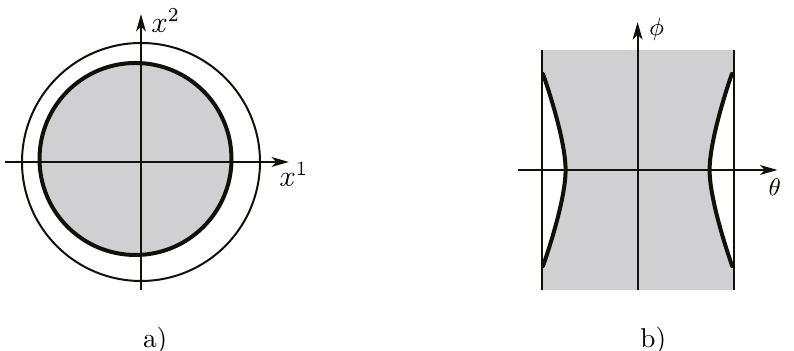
Figure 1 . The Euclidean (a) and Lorentzian (b) geometries in the Jackiw-Teitelboim theory. The physical spacetime (shaded) is embedded in the Poincare disk or the global anti-de Sitter